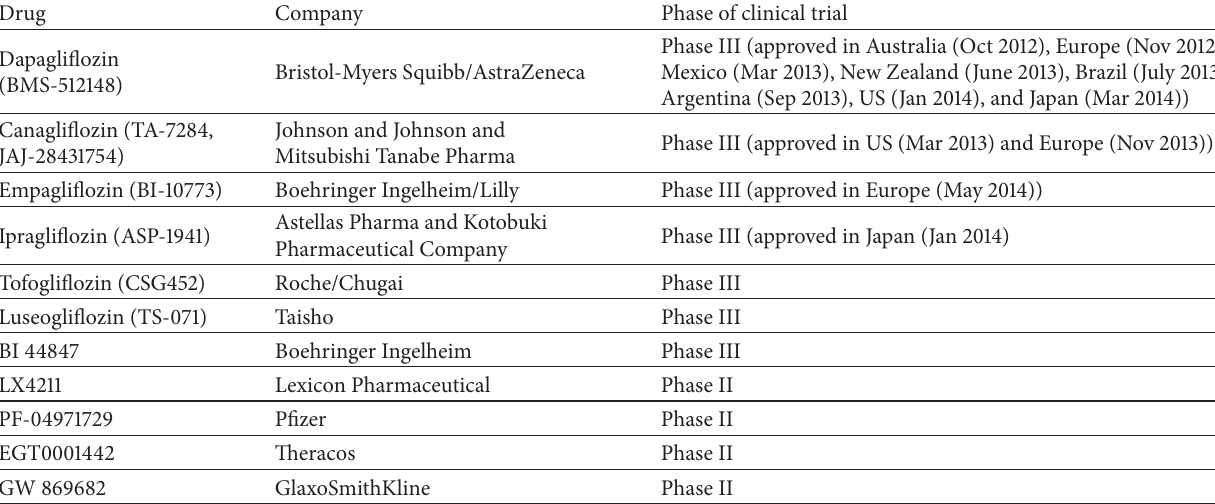
Table 1: SGLT2 inhibitors under phase II and phase III clinical